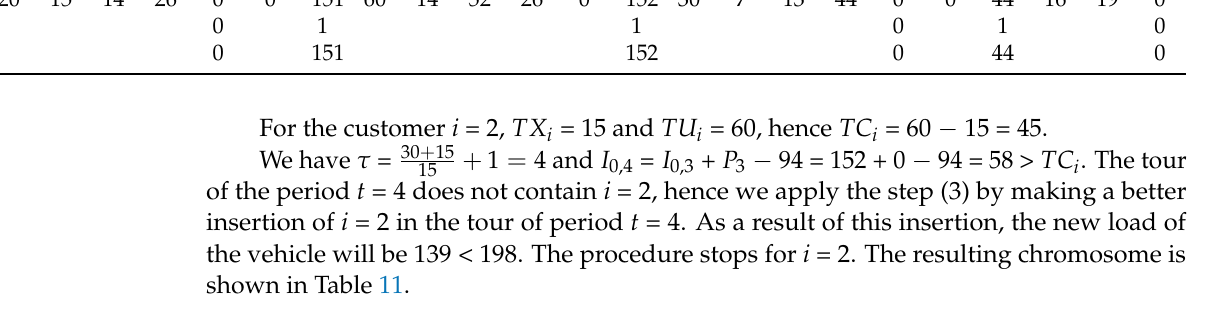
Table 11. Correction for i = 2 in C